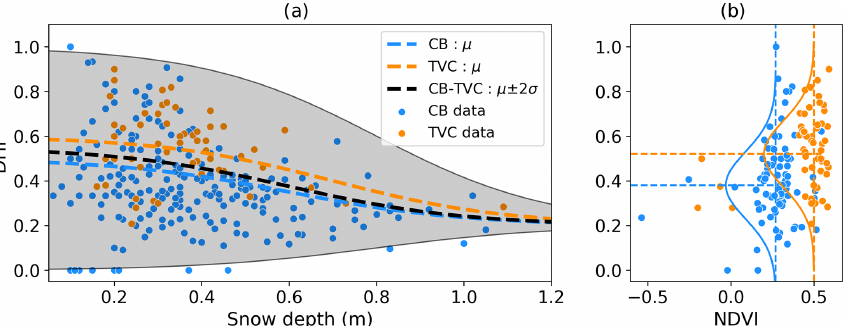
Figure 6. (a) Depth hoar fraction (DHF) as a function of total depth for snow pit data from 2015–2019 in Cambridge Bay and 2018–2019 for Trail Valley Creek. Both datasets were separated in equal bins (10cm) to estimate the mean value shown with the dashed line. The black line represents the mean for both sites with the 95% confidence interval. (b) DHF is shown as a function of NDVI from the snow pit area with the mean DHF and NDVI per site shown by dashed lines and the Gaussian distributions of DHF by the solid